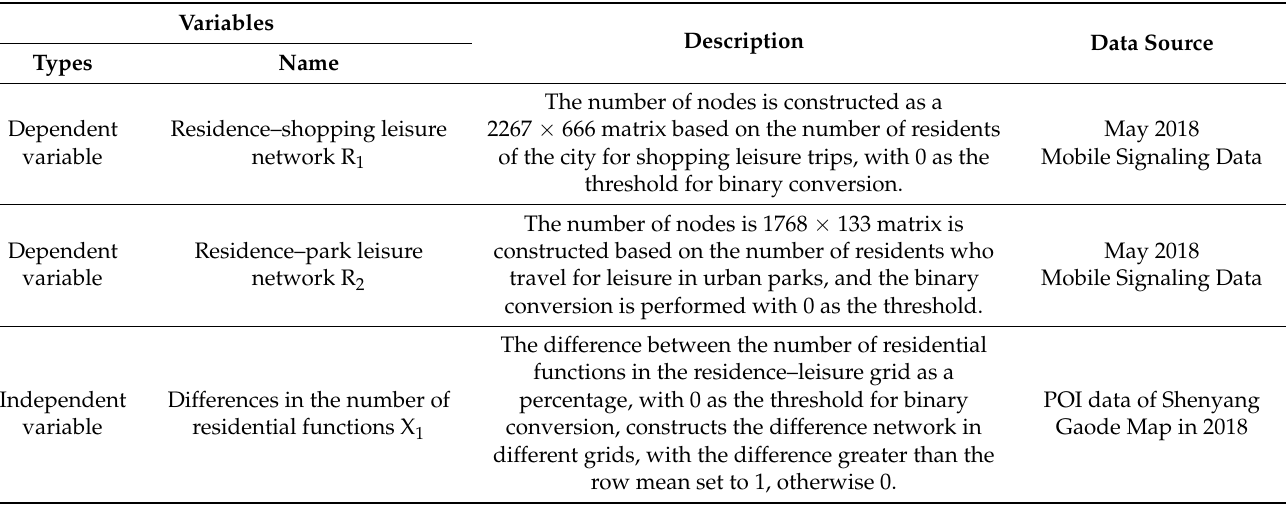
Table 2. Description of the variable matrix of the residence–leisure network